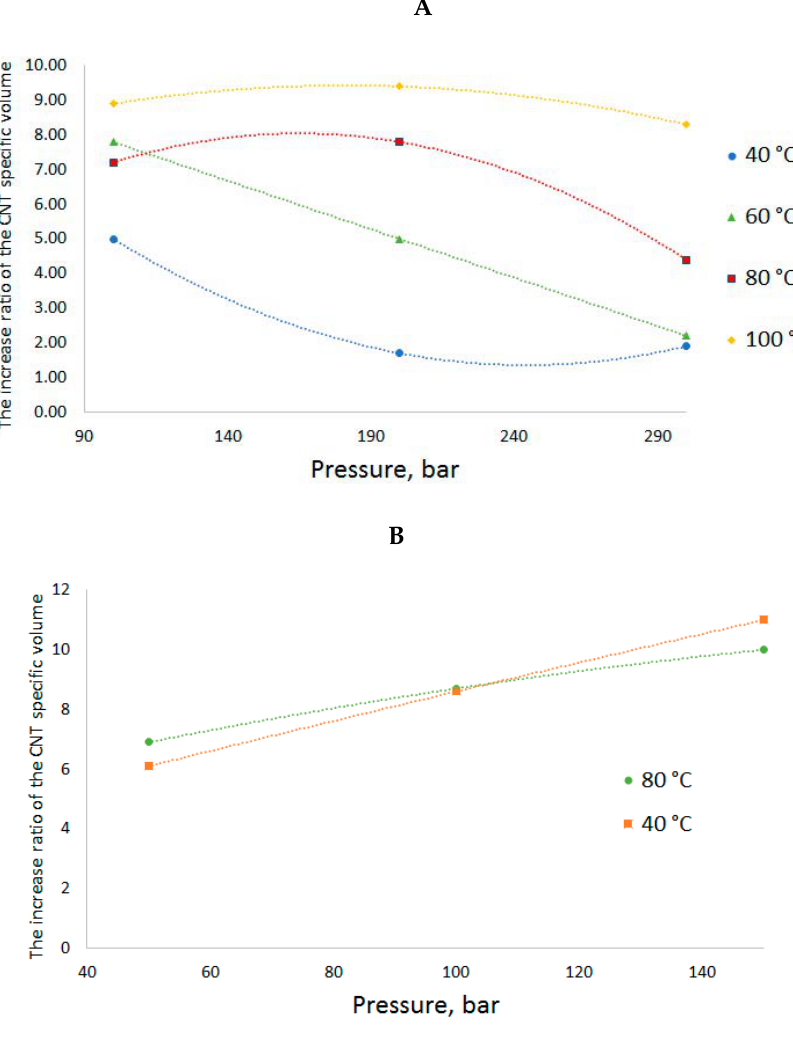
Figure 6. The increase ratio of the CNT specific volume after RESS-processing using CO 2 ( A ) and N 2 ( B ) at different conditions.